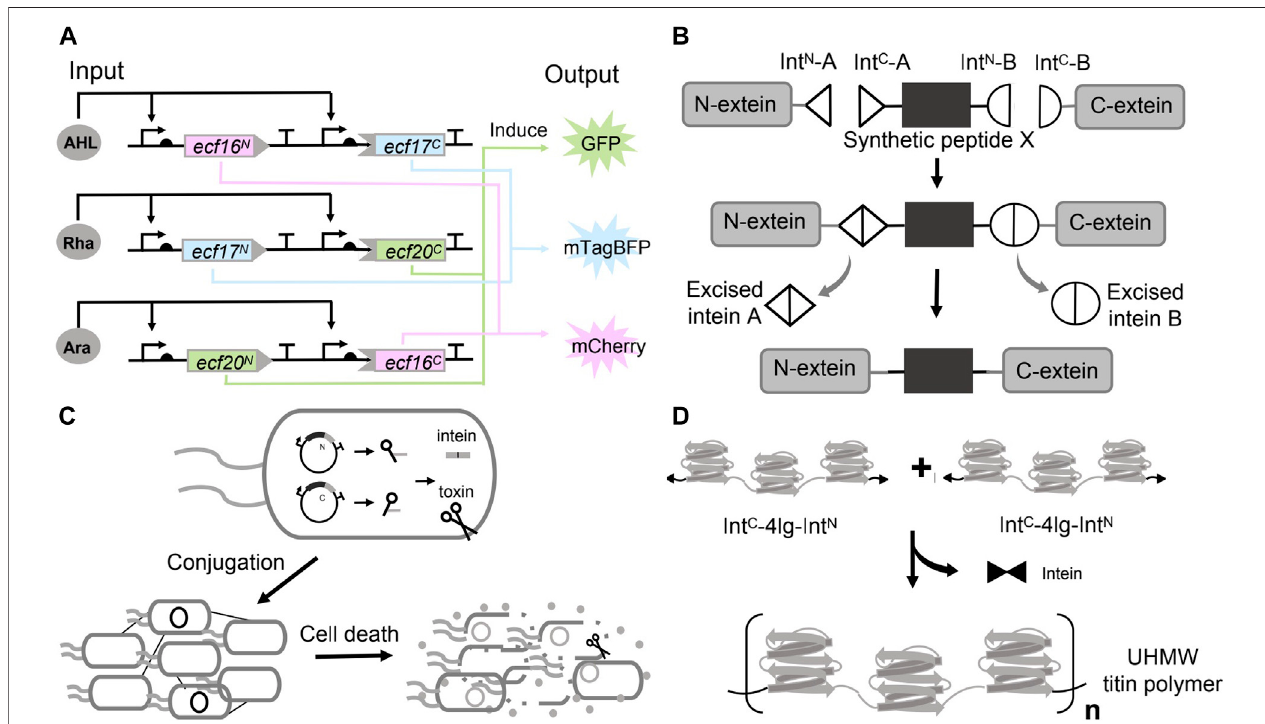
FIGURE4| Useofinteinsinsynthetic biology. (A) Applying inteinstoimplement biocomputing. (B) Chemical modi fi cationofpeptideor protein byinteinsmediated protein splicing. (C) Living therapeutics constructed by the inteins directed splicing. (D) Materials assembly by protein splicing of inteins.